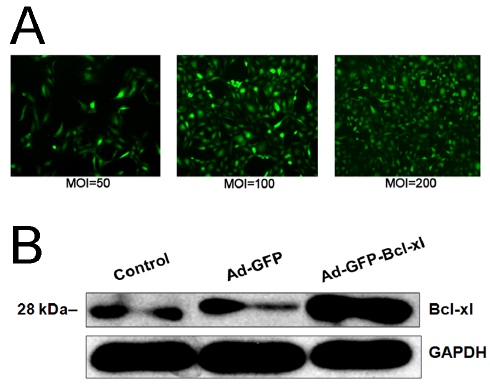
Figure 1. HUVECs infection with recombinant adenovirus (Adv-GFP- Bcl-xl ) or empty virus (Adv-GFP) and the expression of Bcl-xl by Western blotting. ( A ) Observation of HUVECs infected at different multiplicities of infection (MOI) for 48 h by fluorescence microscopy (×40). Green fluorescence represents infected cells; ( B ) Bcl-xl expression in HUVECs of different groups by Western